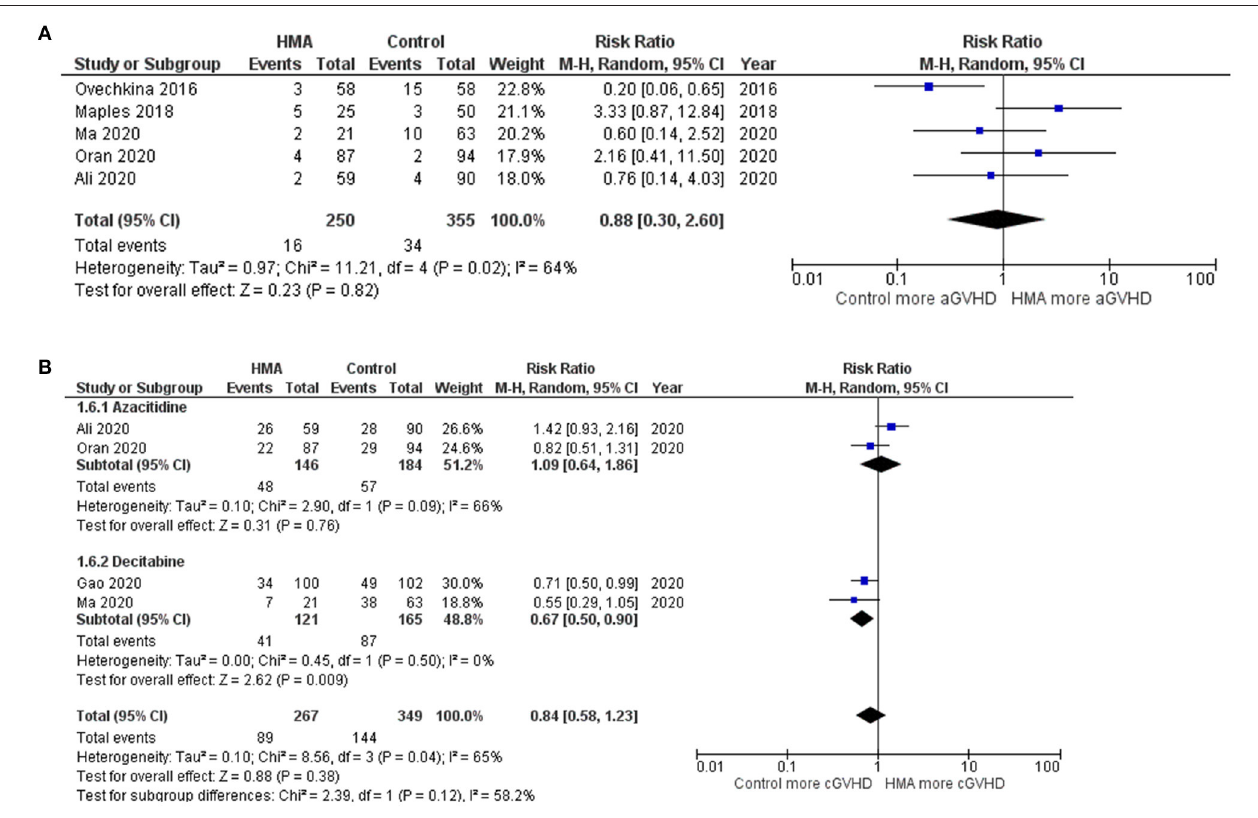
FIGURE 4 | Forest plots of the meta-analysis of HMA maintenance compared with no HMA maintenance. (A) grade III–IV aGVHD rate. (B) cGVHD